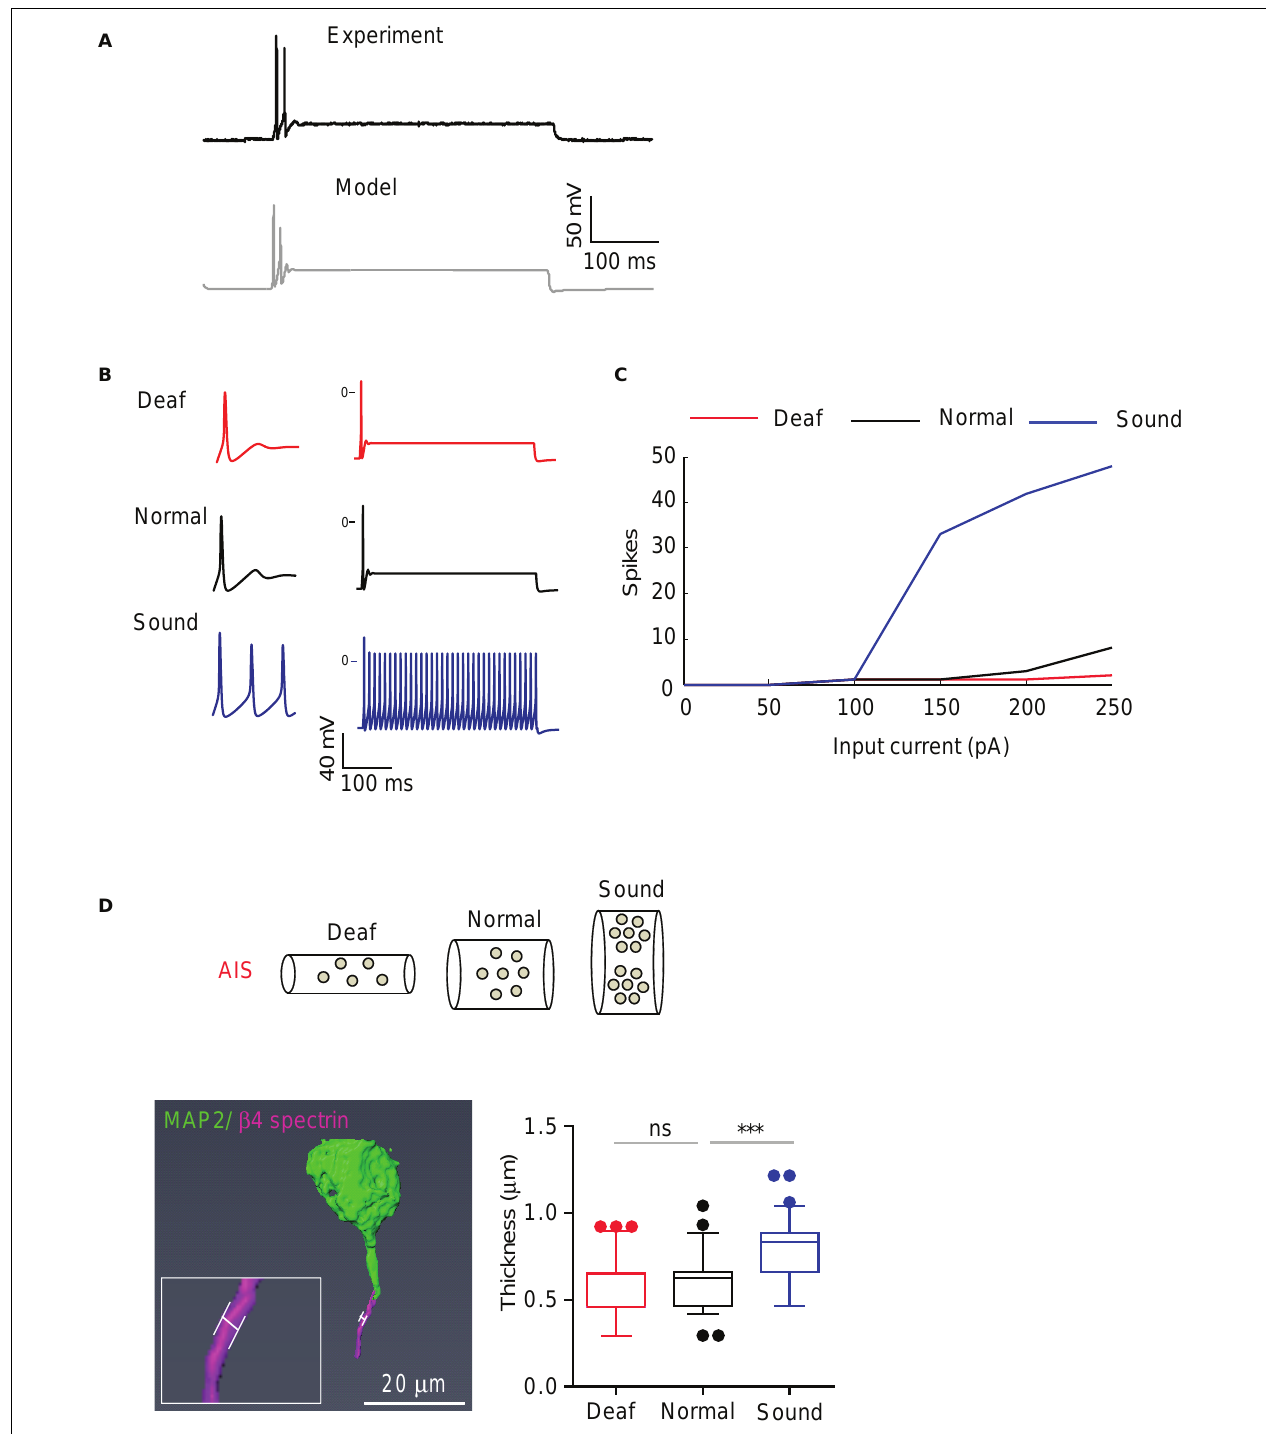
FIGURE 8 | AIS structural changes in sound stimulated group are associated with alteration in firing properties. (A) Representative AP evoked by current injection (200 pA) from MNTB neurons in normal hearing mouse (black, experiment) and modeling of MNTB neuron from a computer simulation (gray, model). (B) Representative traces of the model when stimulated by 200 pA of constant current with parameters that correspond to the Deaf, Normal, and Sound. (C) Summary of AP number evoked by current injection (50 pA–250 pA) from Deaf (red), Normal (black), and Sound (blue) using computer simulation (top). (D) Expected AIS structure with ion channel expression from Deaf, Normal, and Sound (bottom). Note, axon diameter is changed in sound modified groups. Bottom, an example of 3D reconstruction of MNTB neuron at P20 mice immunostained with β 4 spectrin and MAP2. The white line indicates the thickness of AIS (left). Summary of AIS diameter from Deaf (red), Normal (black), and Sound (blue). ∗∗∗ p < 0.0001, one-way ANOVA with Turkey’s multiple comparison test.